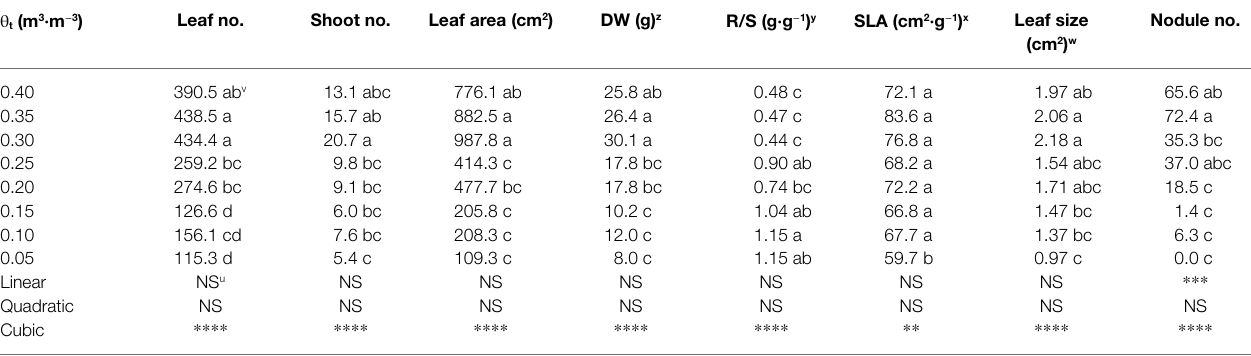
TABLE 3 | Number (no.) of leaves and shoots, total leaf area and dry weight (DW), root to shoot ratio (R/S), specific leaf area (SLA), leaf size, and nodule no. of Shepherdia ×utahensis at eight substrate volumetric water content treatments ( θ t ) at the termination of the experiment. θ t (m 3 ·m − 3 ) Leaf no. Shoot no. Nodule